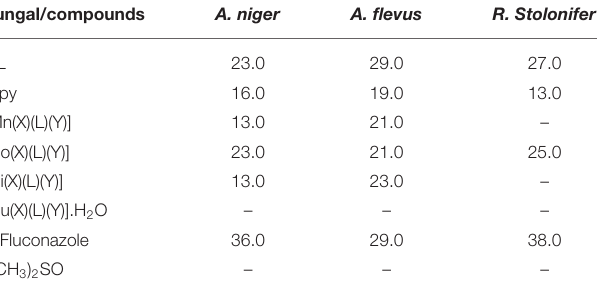
TABLE 3 | Antifungal data of HL, 2,2 ′ -bipy and its heteroleptic complexes. Fungal/compounds